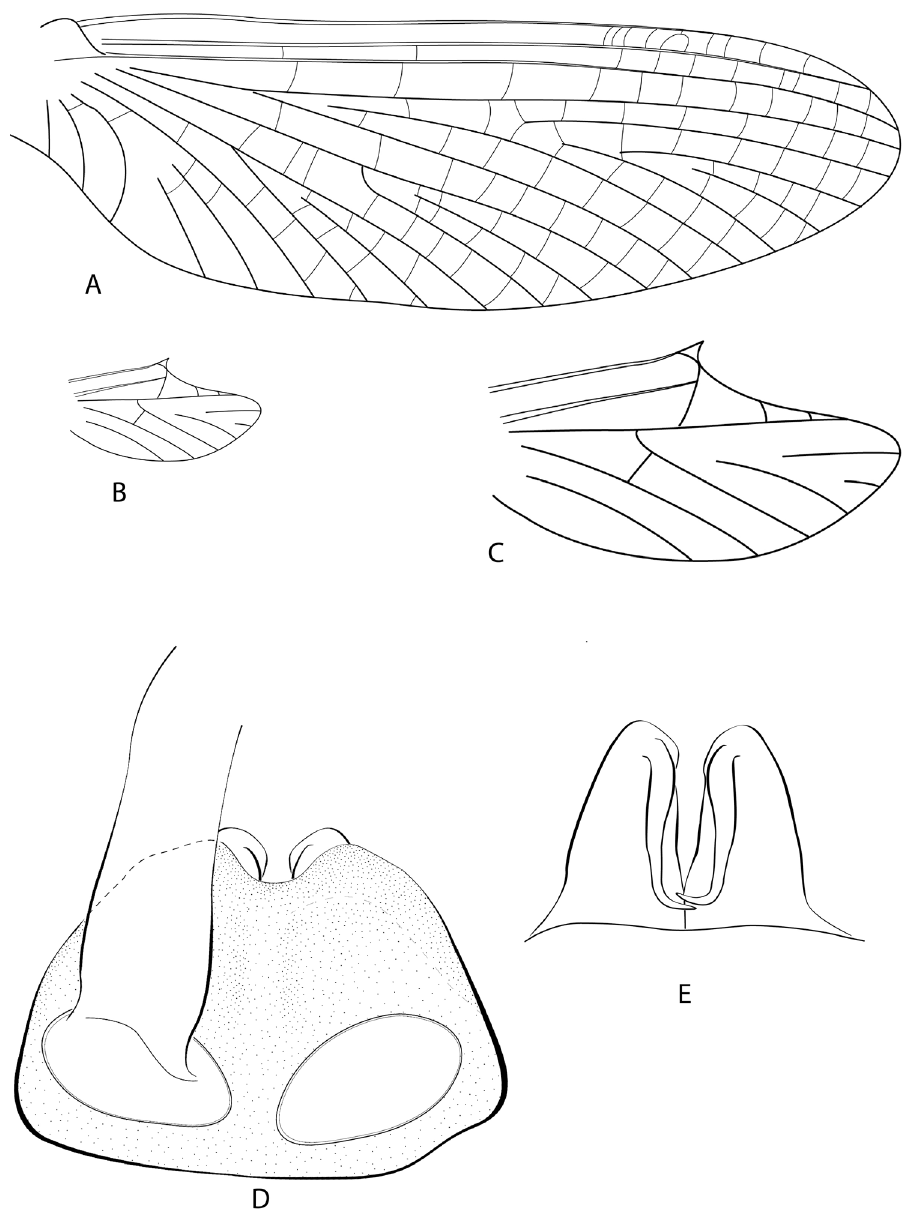
Figure 6. Leentvaaria palpalis , male imago: a fore wing b hind wing c hind wing, enlarged d genitalia, ventral view e penis, ventral